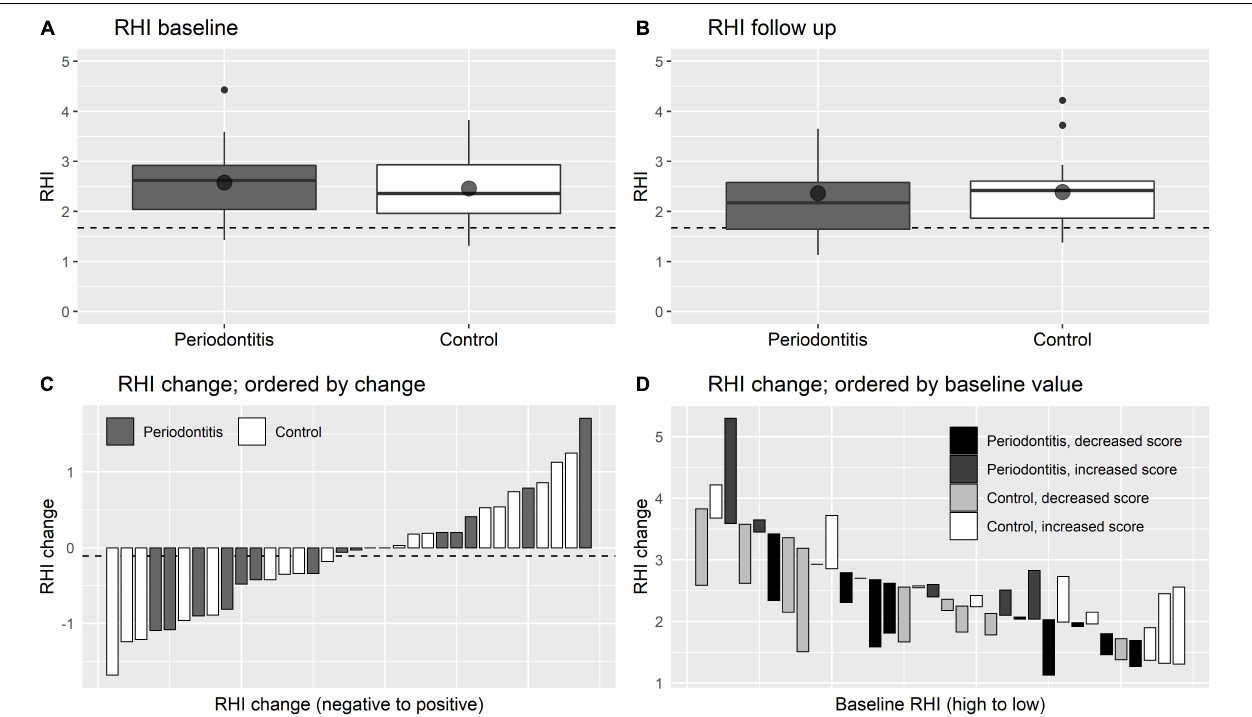
FIGURE 2 | Changes in endothelial function (RHI). (A,B) Are boxplots showing the distribution of RHI at baseline and at follow up, respectively Point shapes indicate sample means. The dashed line presents RHI cut-off score of 1.67 that correlates to endothelial dysfunction. (C,D) Are waterfall plots showing the change of RHI while ordered by the extent of RHI change and ordered by baseline RHI, respectively. In (C) the dotted line indicates mean RHI change for periodontitis patients. TABLE 4 | Differences in cardiovascular change between periodontitis patients and controls. Change periodontitis Change control Difference p